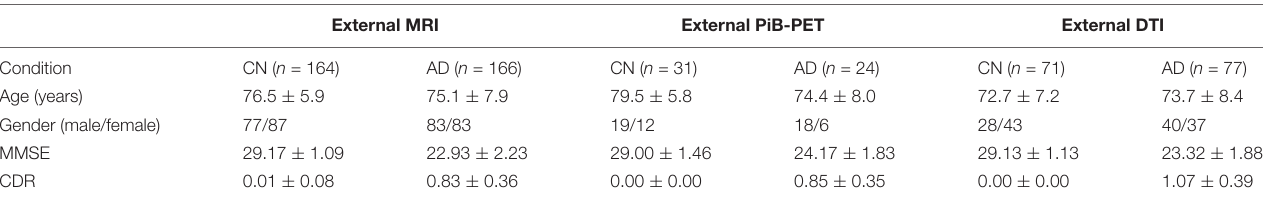
TABLE 2 | Demographics and neuropsychologic characteristics for the ADNI external data. External MRI External PiB-PET External